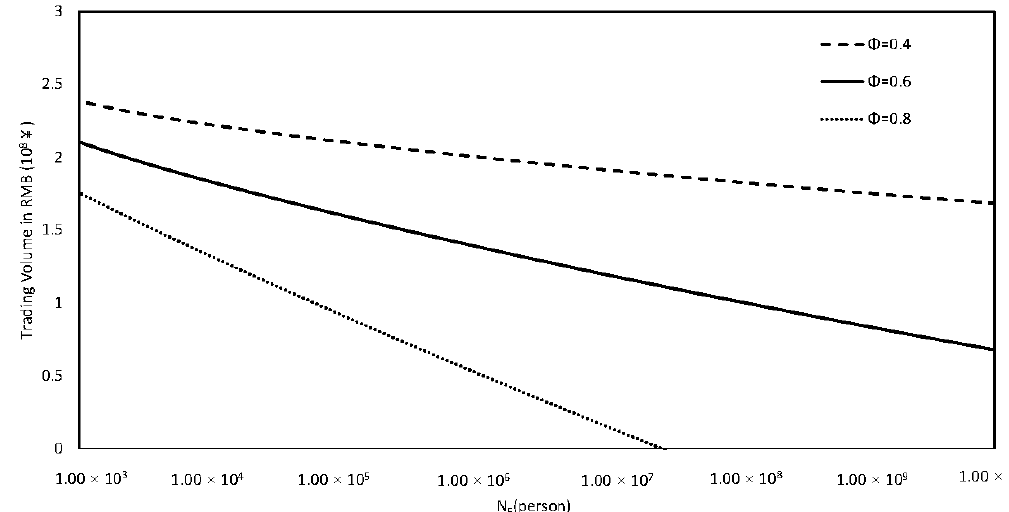
Figure 3. Relation of trading volume in RMB (Chinese money) to rural population N F . (The trading volume is the transaction volume T multiplied by the transaction price P mar .).